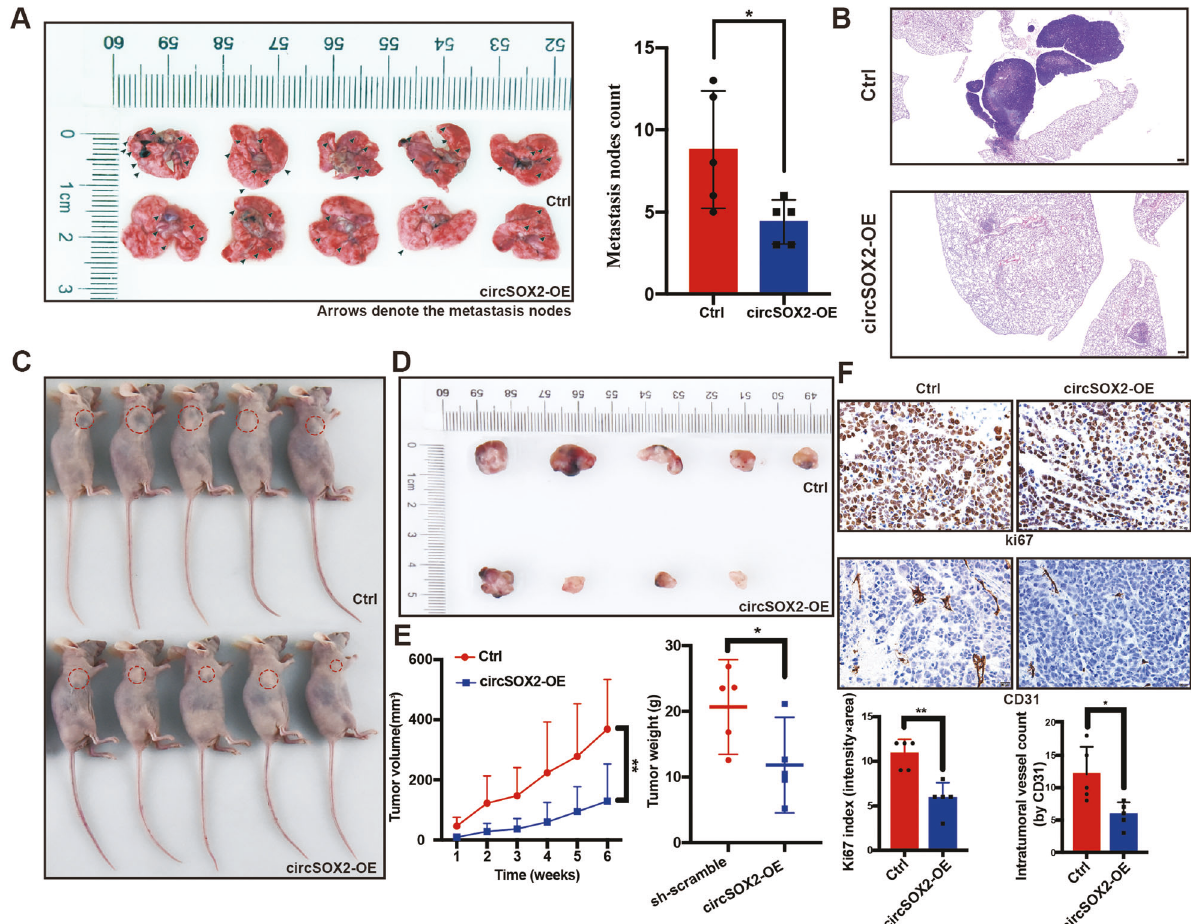
Fig. 3 CircSOX2 suppressed the malignant progression of LUSC in vivo. A BALB/c nude mice were injected with cells (Ctrl and circSOX2-OE) via the tail vein and evaluated the metastasis. B The tumor width of the Ctrl group was bigger than the circSOX2-OE group. C and D CircSOX2 suppressed the growth of LUSC in vivo. E The tumor growth curves and the tumor weights of xenografts were plotted in the Ctrl and circSOX2-OE groups. F The images presented the immunohistochemical staining of Ki67 and CD31 in Ctrl and circSOX2-OE xenografts. ** p < 0.01, * p <